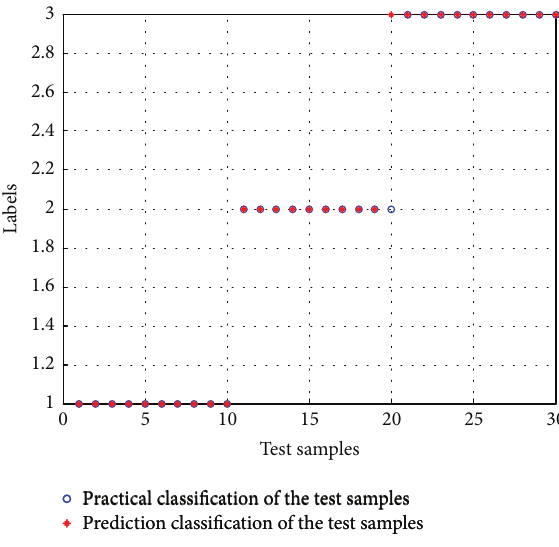
Practical classification of the test samples Prediction classification of the test Figure 8: Recognized results of gear